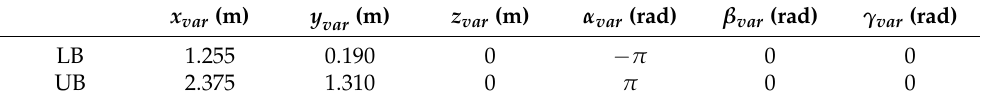
Table 5. Search space defined by lower and upper bounds of the